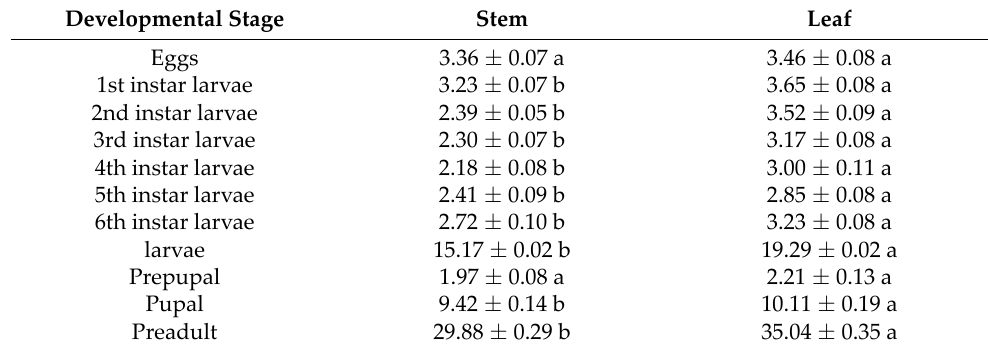
Table 1. Development duration of S. litura fed on different tissues of asparagus.